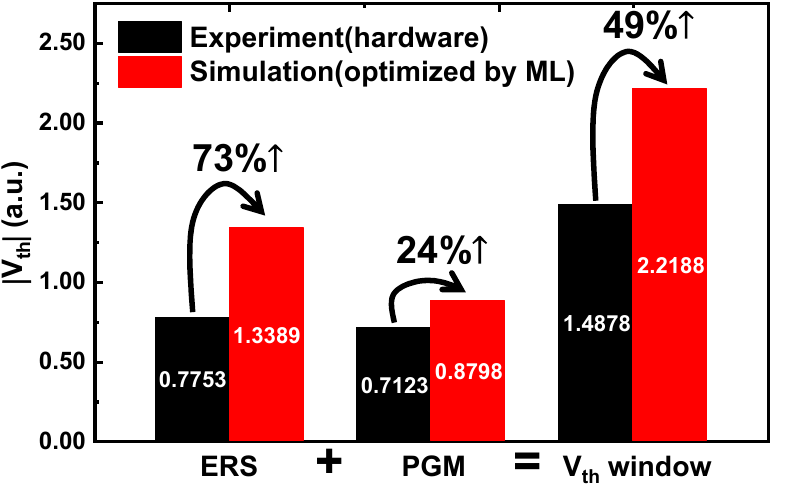
+ = Figure 9. |V th | values in ERS/PGM operations and V th window. Values estimated using ML outperform experimental values overall.